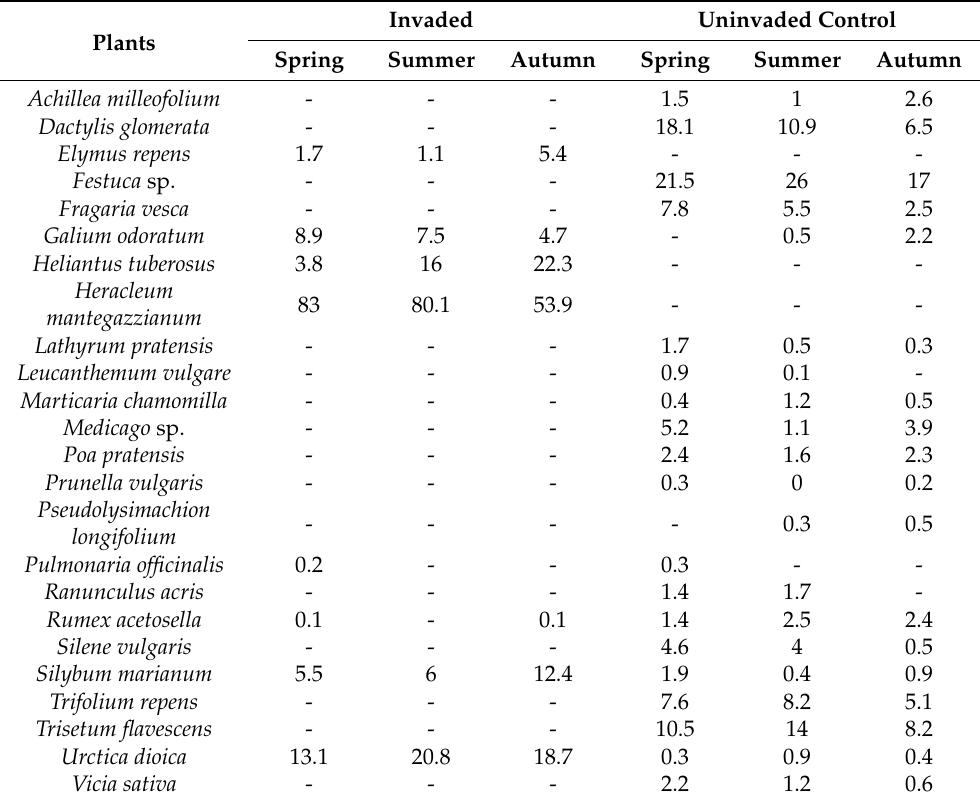
Table 2. Mean percentage of plant cover in the Heracleum mantegazzianum invaded and uninvaded control plots in the three vegetation seasons and two years (2017, 2018) ( n =